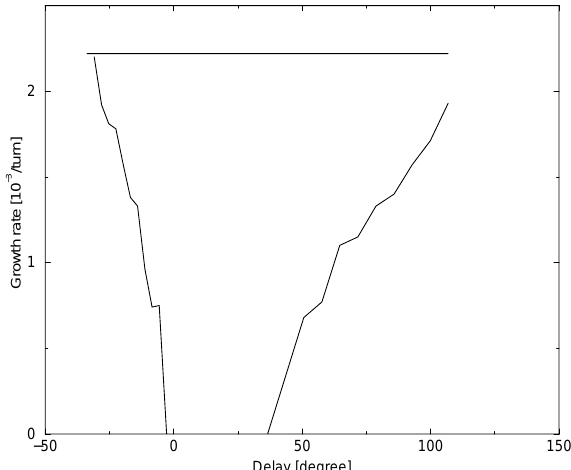
the time delay given as phase (360 ± corresponds to the revolution time). The horizontal line denotes the growth rate in the absence of feedback.